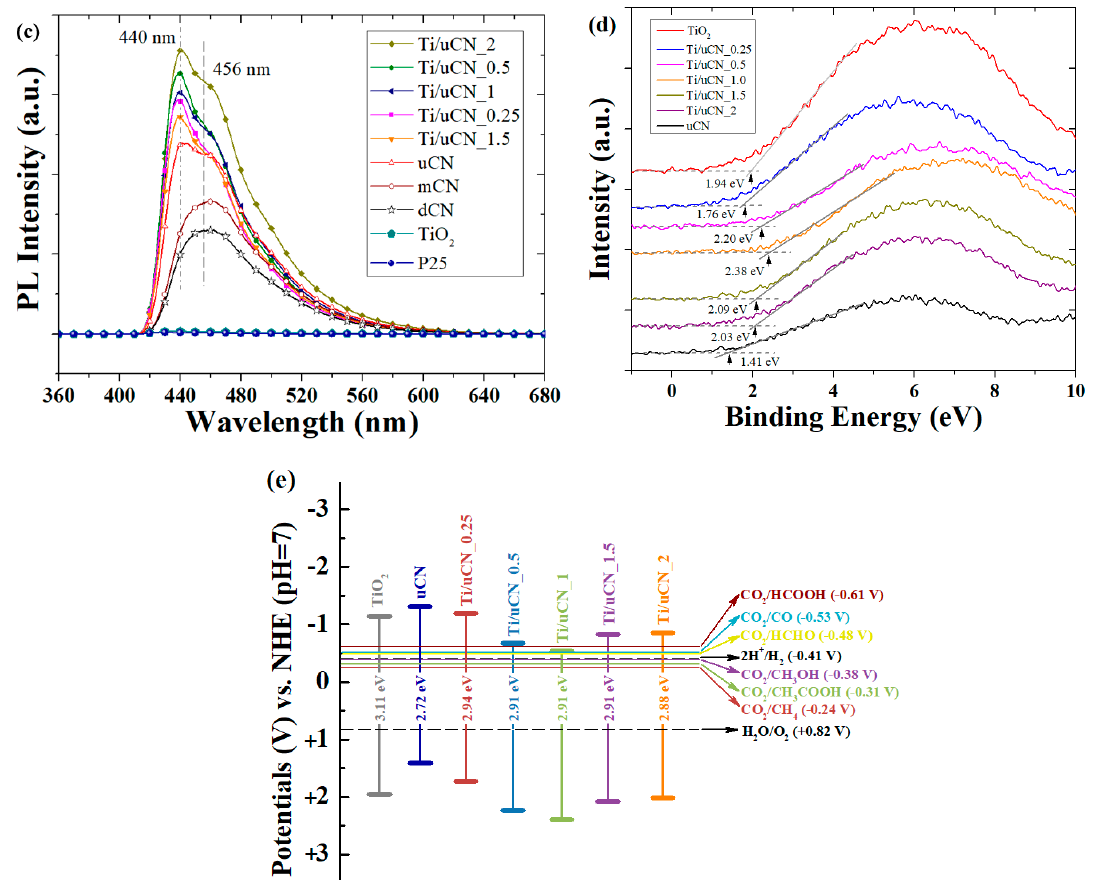
Figure 4. ( a ) Thermogravimetric curves; ( b ) UV-Vis spectra; and ( c ) photoluminescence spectra (Ex. λ = 315 nm); ( d ) XPS valence band spectra of uCN, TiO 2 and Ti/uCN_x; and ( e ) schematic band edge position of samples with respect to redox potentials of species measured at pH 7.